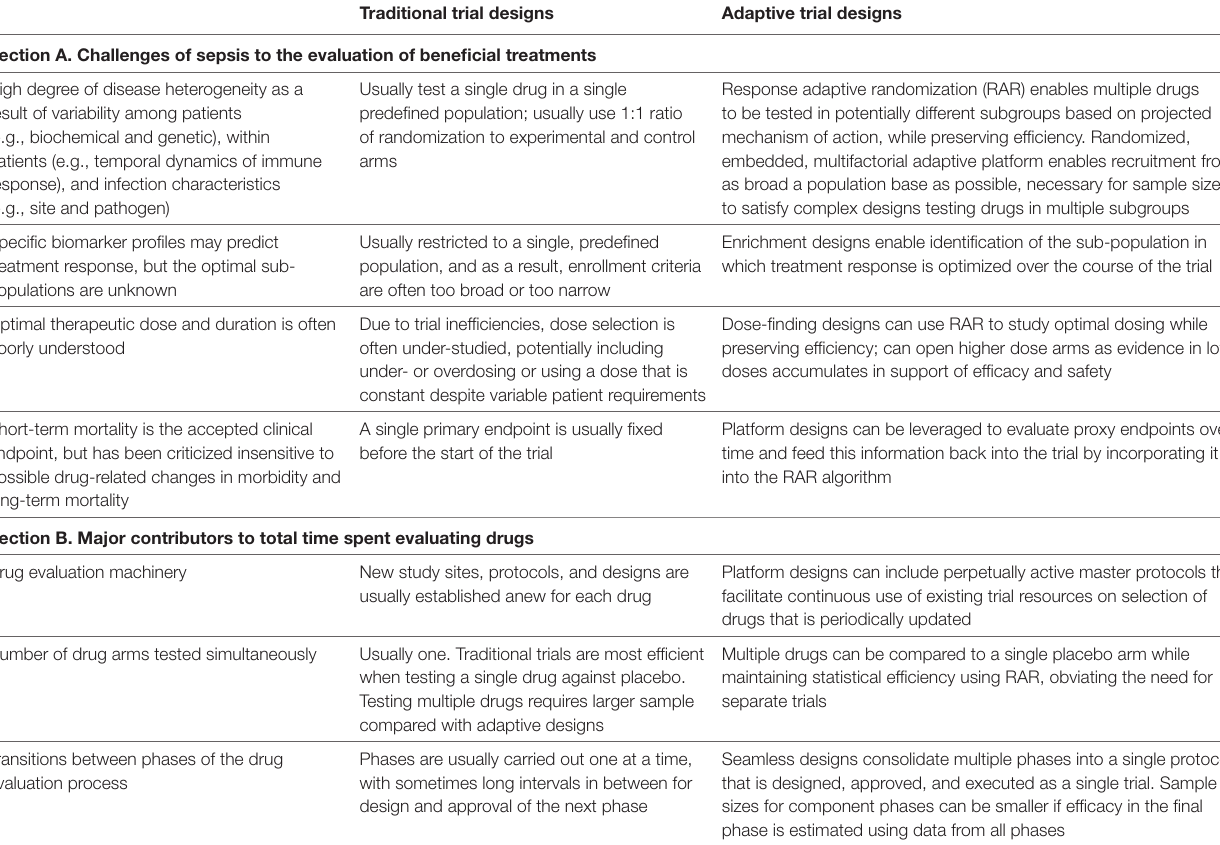
TABLe 1 | Comparison of traditional and adaptive design features in addressing challenges of sepsis to the evaluation of beneficial treatments (section A), and ways in which common features of each influence the total time spent evaluating treatments (section